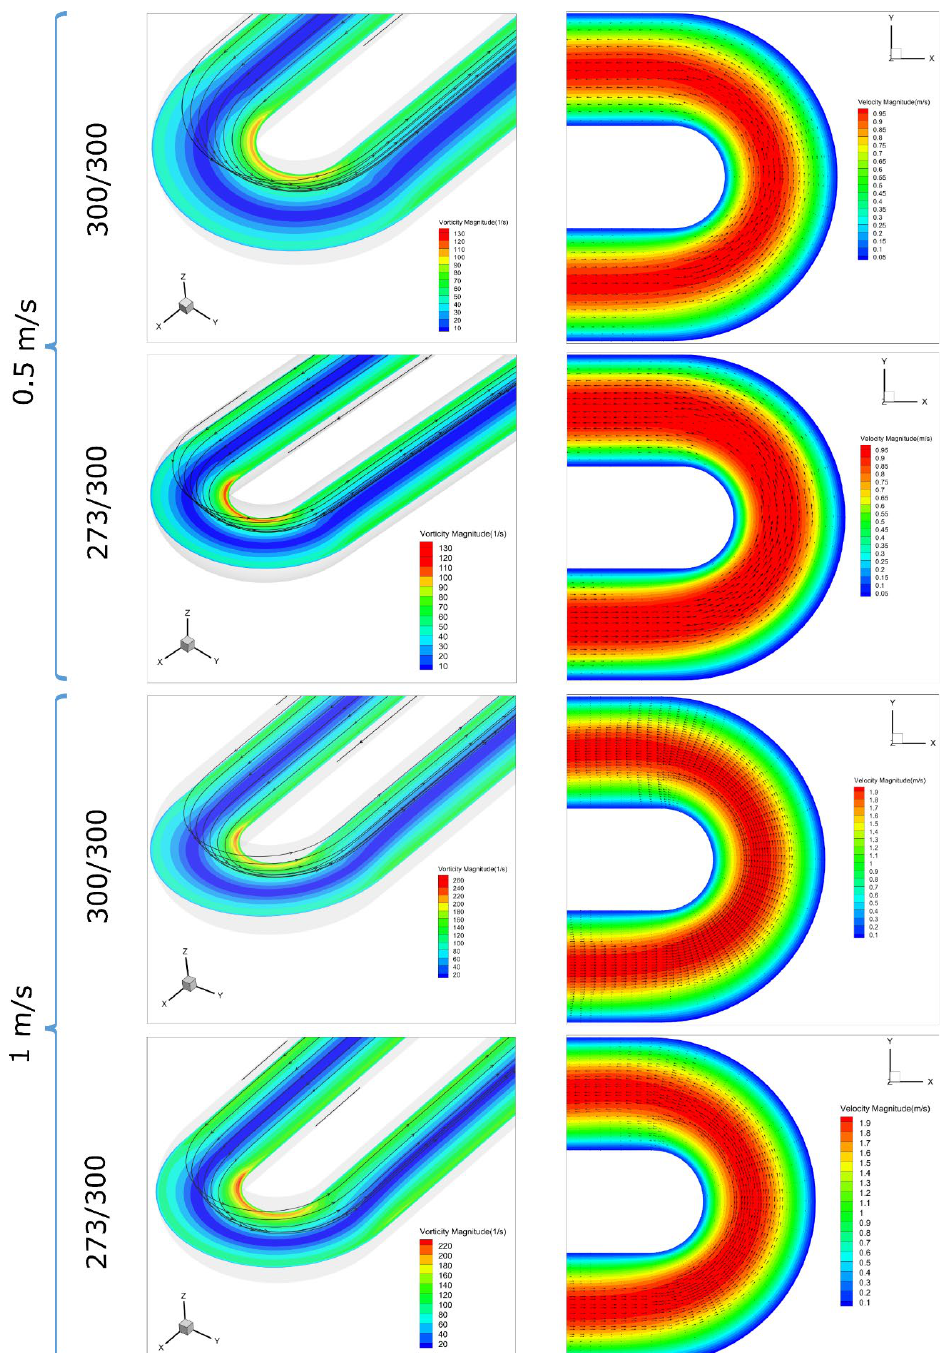
Figure 5. The 3D streamlines, vorticity magnitude, velocity magnitude, and the velocity vector arrows on the middle-height plane of the U-shaped channel. The left column shows the vorticity magnitude and the 3D streamlines. The right column shows the velocity magnitude and the velocity vectors. The first row shows the data at the inlet velocity of 0.5 m/s with no temperature difference. The second row shows the results at the inlet velocity of 0.5 m/s but at the temperature conditions of 273 K on the wall and 300 K of the incoming fluid at the inlet. The third row shows the results at the inlet velocity of 1 m/s with no temperature difference. The fourth row shows the results at the inlet velocity of 1 m/s but at the temperature conditions of 273 K on the wall and 300 K of the incoming fluid at the